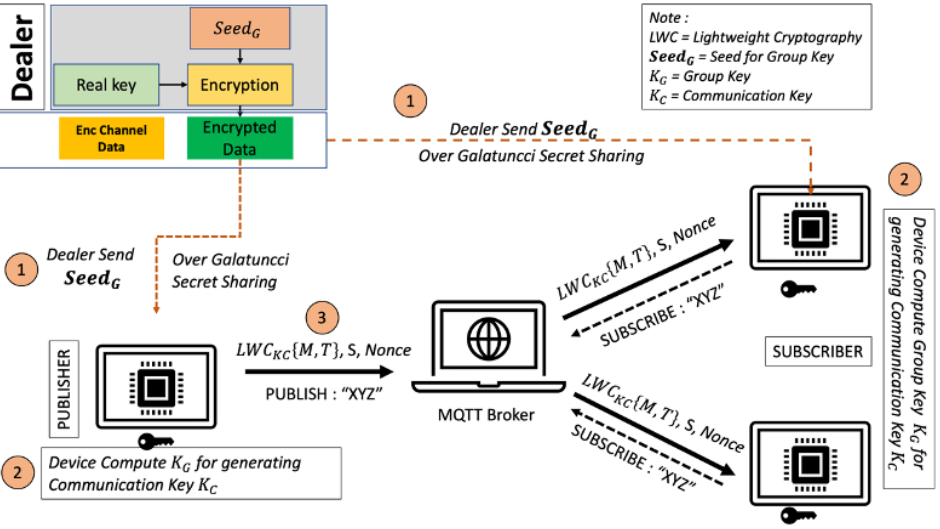
Figure 2. Secure End-to-End Design on MQTT Protocol.